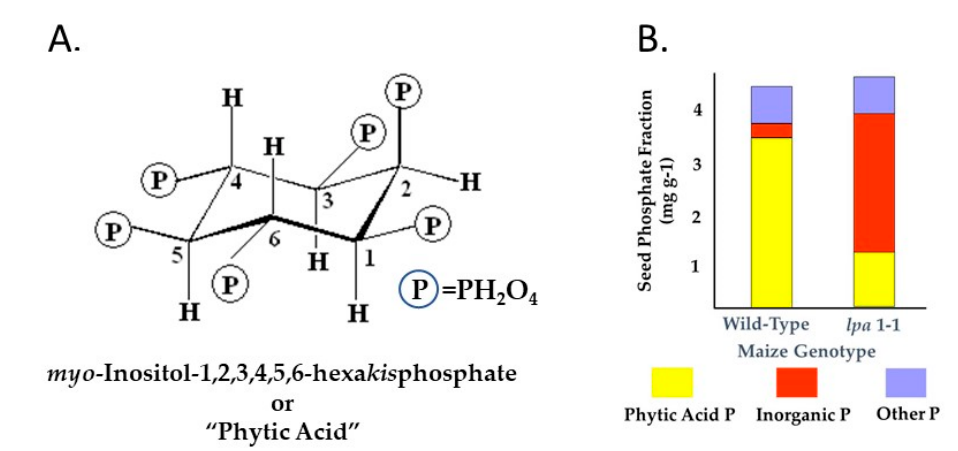
Figure 1. ( A ) Phytic acid, myo-inositol-1,2,3,4,5,6-hexakisphosphate. ( B ) The basic seed phosphorus (P) phenotype of “normal phytic acid” or wild-type and low phytic acid ( lpa ) genotypes, as illustrated by the initial analyses of wild-type and low phytic acid 1-1 maize isolines [2]. While seed total P may vary in any given genotype depending on various environmental, non-genetic factors, the relative contributions of phytic acid P, inorganic P and “other P” to seed total P typically remain fairly constant. “Other P” refers to all P other than phytic acid P and inorganic P, such as P found in other inositol phosphates, DNA, RNA, protein, carbohydrate, lipids, etc.